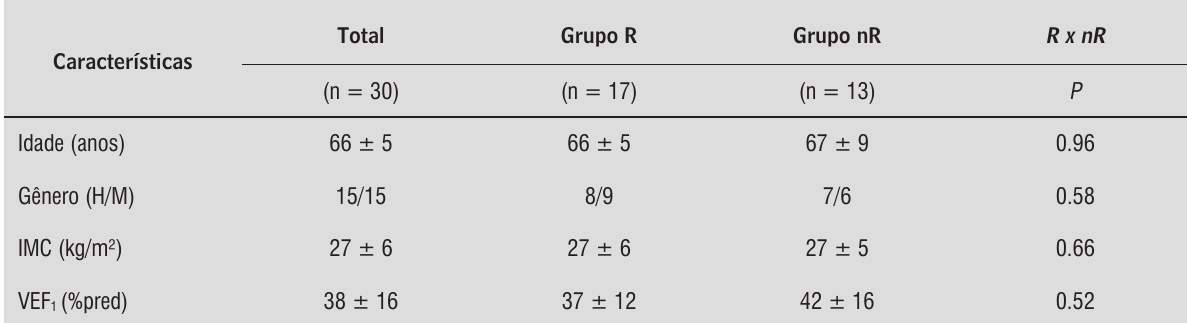
Tabela 1 - Características da população estudada e comparação entre os valores basais do grupo de pacientes responsi- vos (R) e não responsivos